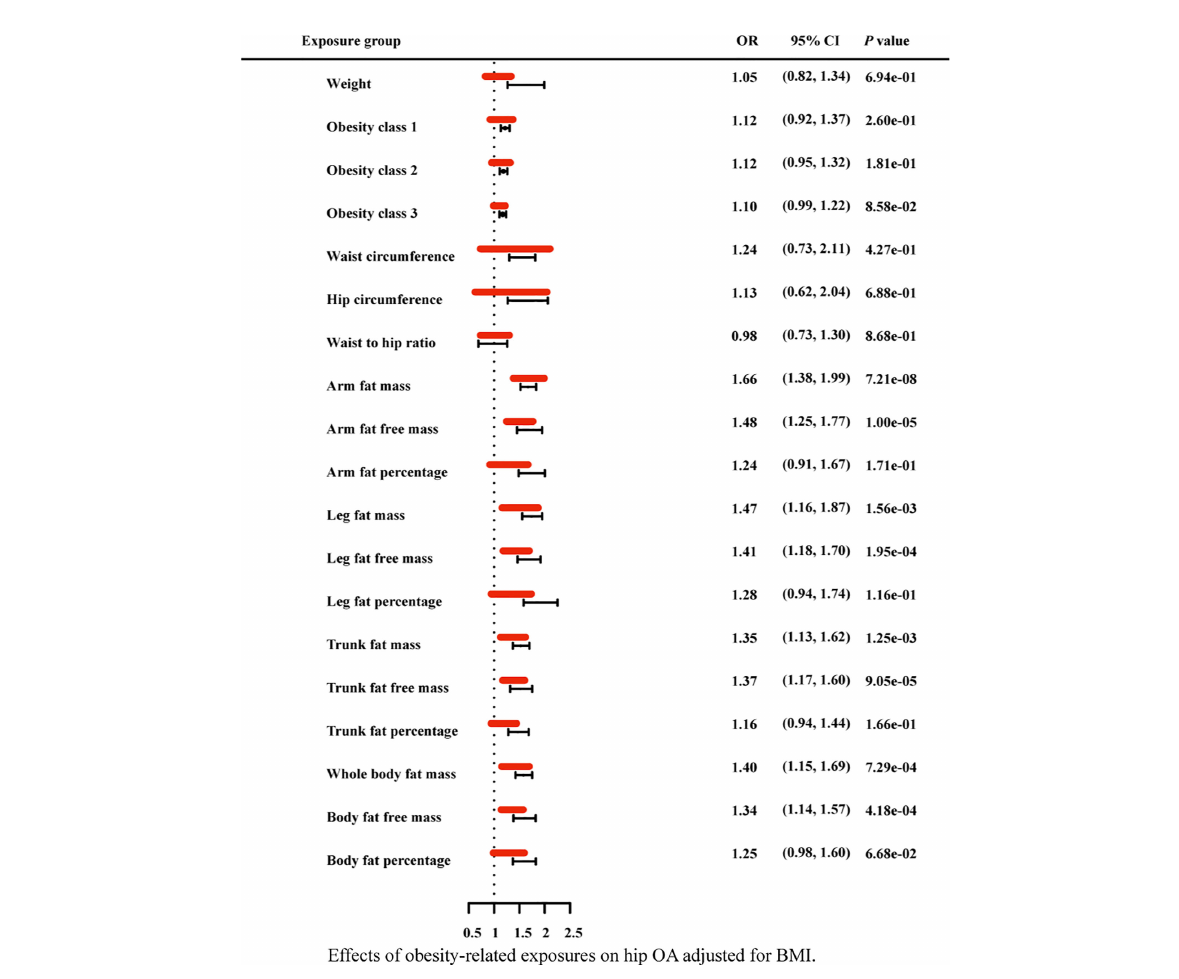
FIGURE 8 Effects of obesity-related exposures on hip OA adjusted for BMI. Results from multivariable MR analyses showing the effects of genetic predicted obesity related anthropometric indicators and body compositions on hip OA after adjusting for the effect of BMI, represented by red